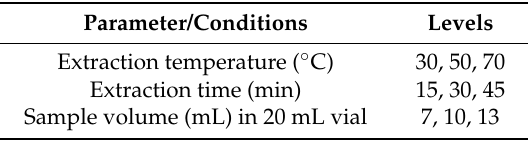
Table 2. The Box-Behnken (three-factor)